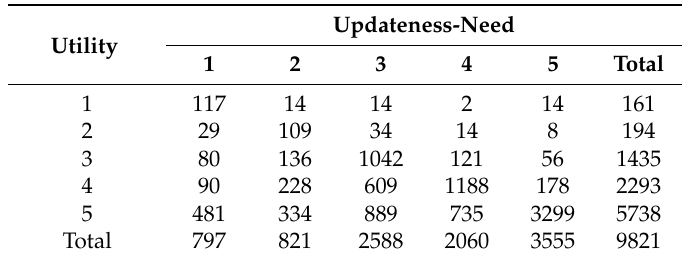
Table 11. Correspondence of cases between Updateness-need and Utility scores.